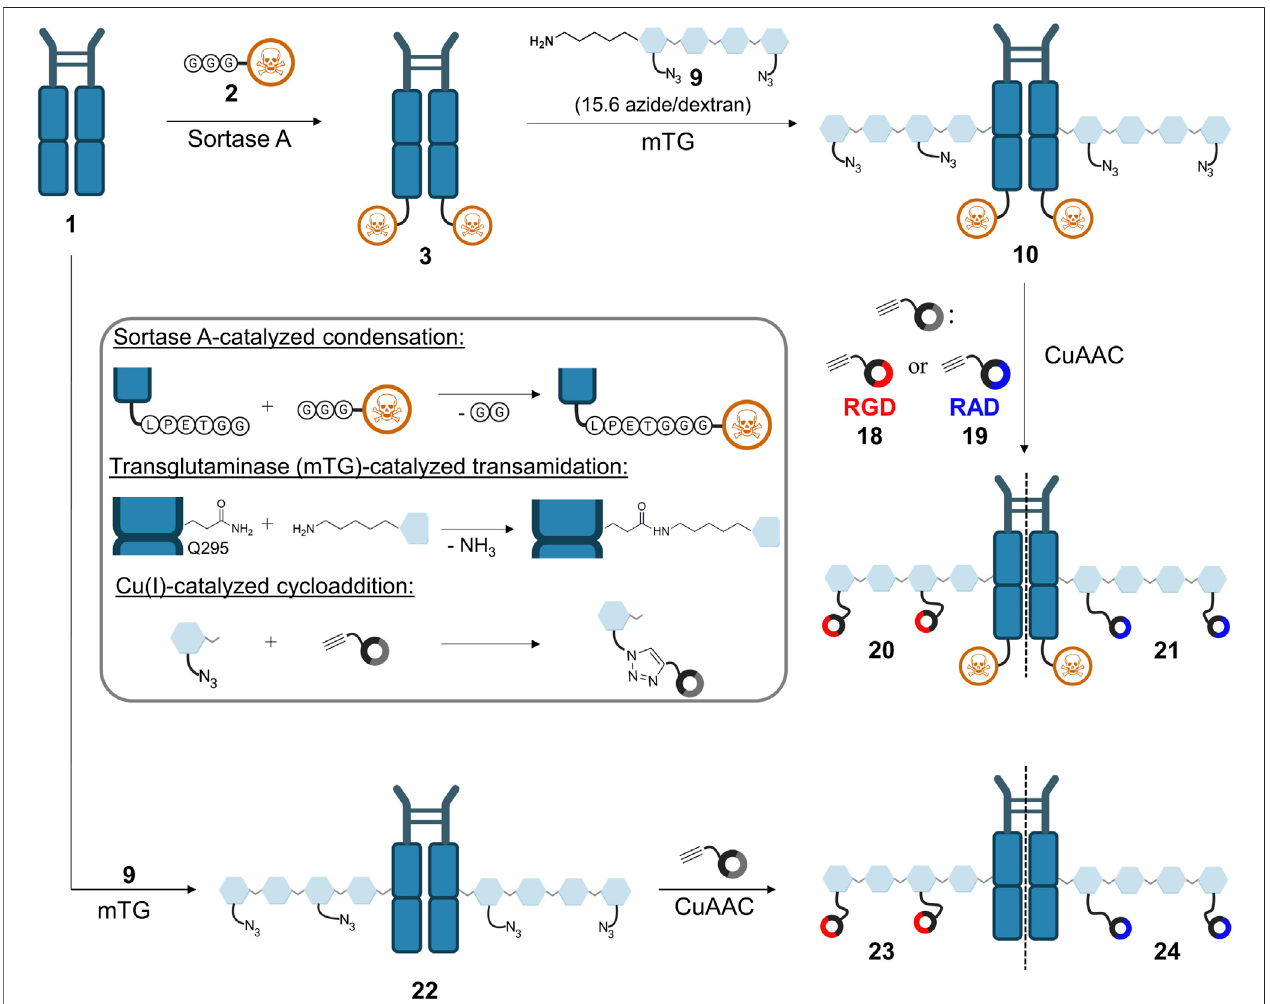
FIGURE 2 | Synthetic approach toward the fi nal constructs 20 and 21 , starting with sortase A-mediated conjugation of MMAE 2 to Fc 1 , followed by transglutaminase-catalyzed conjugation ofazide-decorateddextran 9 . Construct 10 wasfurther functionalizedvia CuAACwith either alkyne-decorated RGD 18 or RAD 19 toyield fi nalconstructs 20 and 21 .Alternatively,Fc 1 wasdirectlyfunctionalizedwithdextran(construct 22 )andfurthermodi fi edviaCuAACtoobtainRGD-decorated 23 and RAD-decorated 24 . Figure was created with